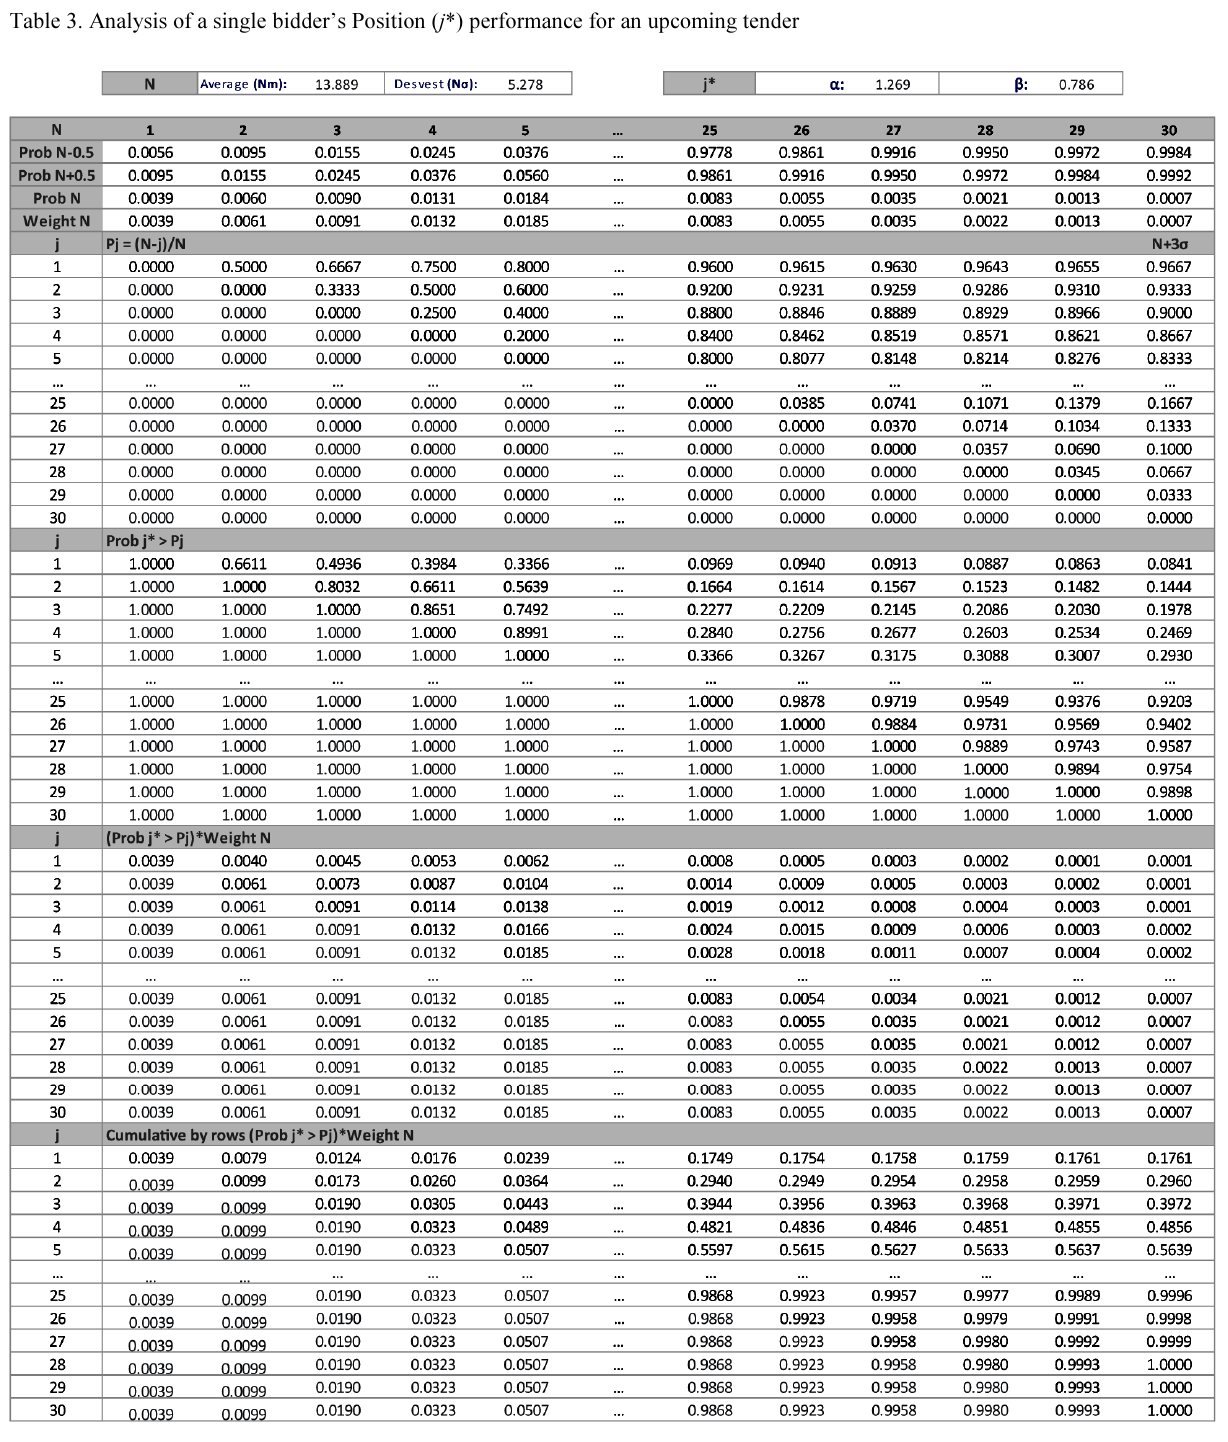
Figure 3 is easily obtained by representing in a dif- ferent graph the values from the Figure 2 X-axis when N = 30 bidders, that is, values from j = 1 to 25 when N = 30 (lowest right-hand corner of Table